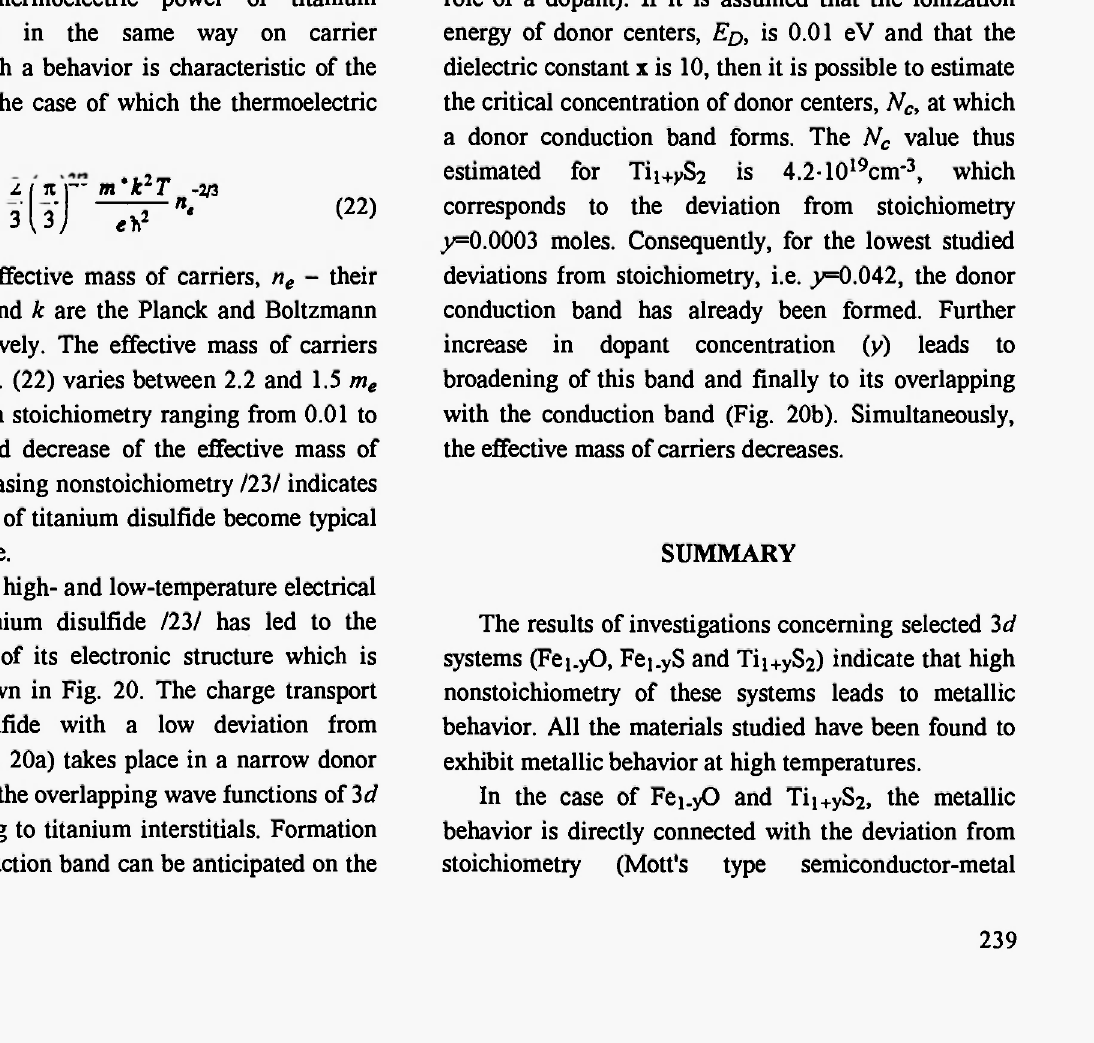
Fig. 19: Thermoelectric power of titanium disulfide as a function of its composition at constant temperature.